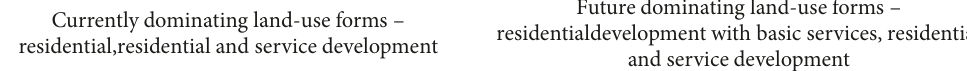
Table 3: Currently dominating and future land-use forms [ha]; changes in the area of residential and service developments within an area of 660 m radius from the PMR stations in Gda´nsk.